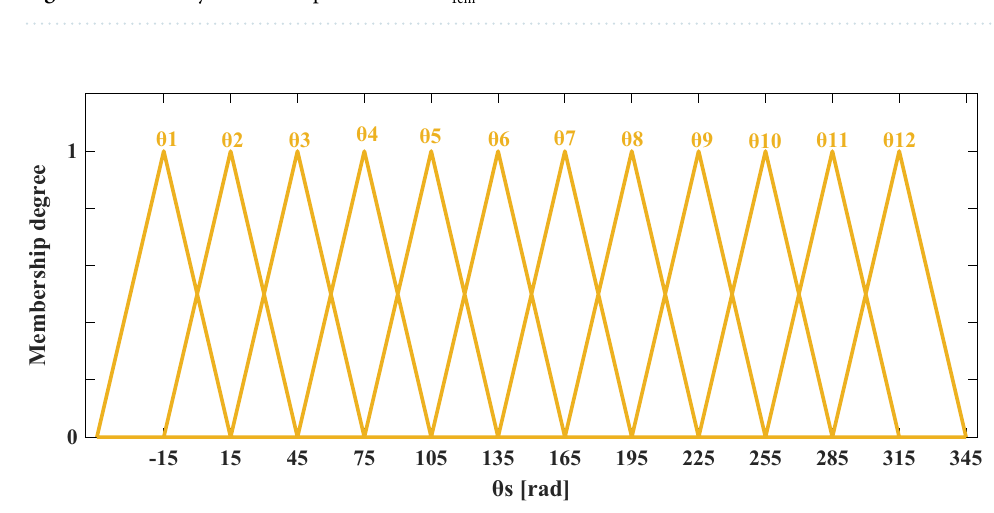
Figure 4. The fuzzy membership functions of ε Tem .